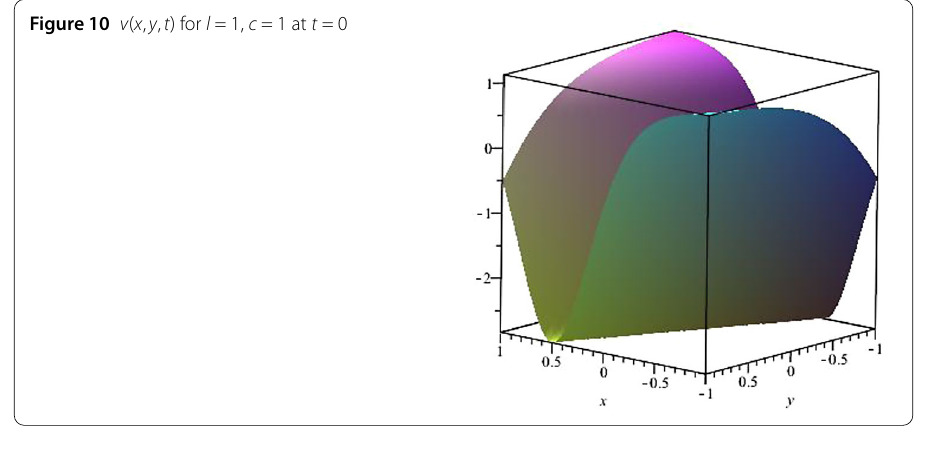
Figure 10 v ( x , y , t ) for l = 1, c = 1 at t =